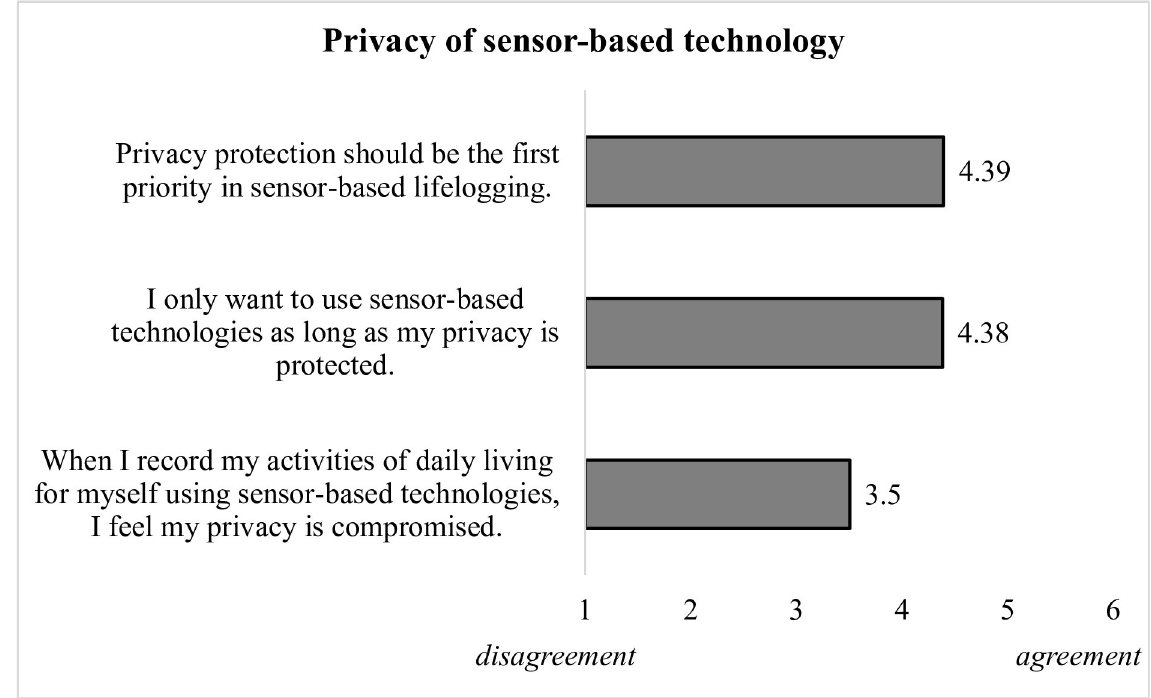
Fig 7. Evaluations of privacy in the context of sensor-based